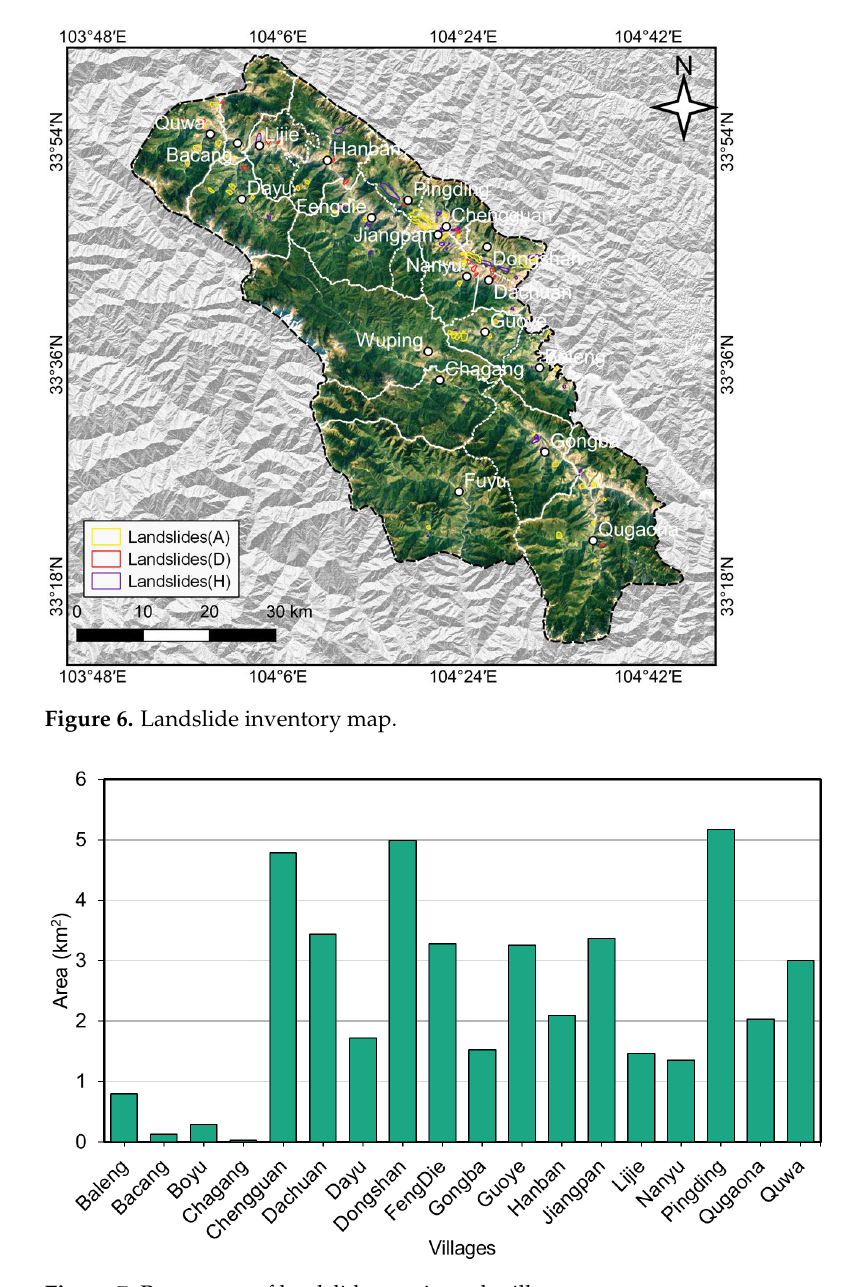
Figure 5. Stacking-InSAR landslide detection results based on descending data: ( a ) Stacking-InSAR phase results; ( b ) typical landslides; ( c ) distribution of cracks and local landslides of the L14 land- slide; and ( d ) distribution of gullies and local landslides on the L16 landslide.